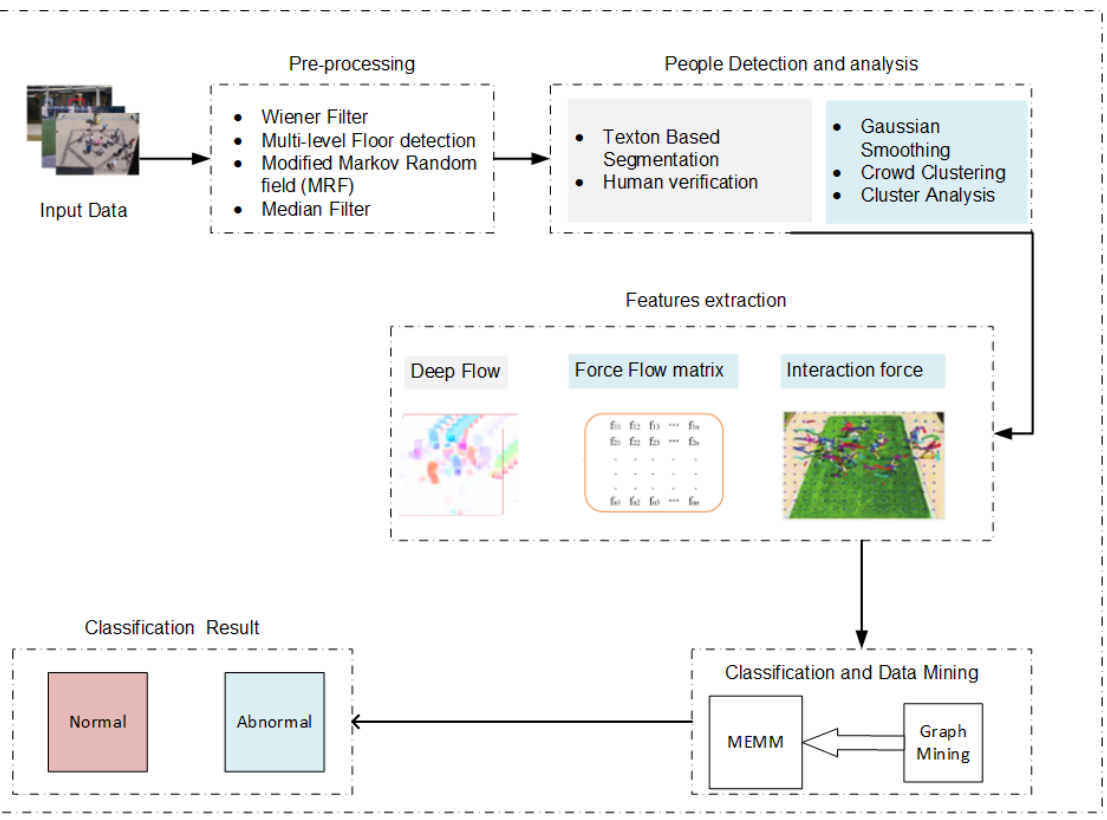
Figure 1. Flow diagram of proposed human normal and abnormal activity detection model.